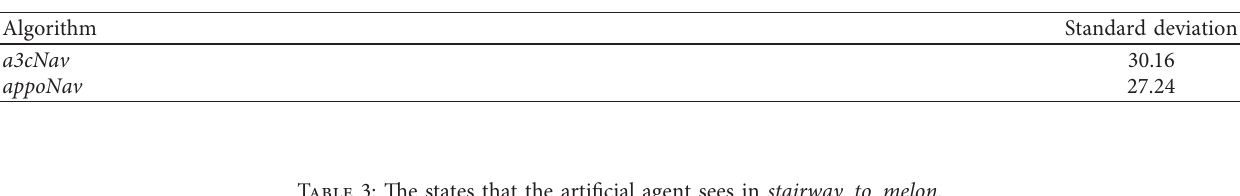
Figure 2: Reward achieved by the artificial agent in stairway_to_melon . Table 2: Standard deviation of the reward in stairway_to_melon .